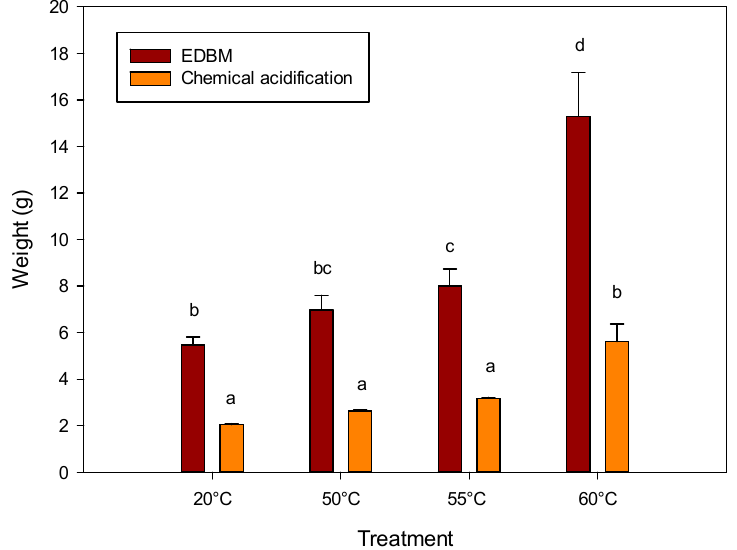
Figure 2. Weight of freeze-dried precipitate fractions generated at pH 4.8 after both acidification methods. The results are presented as the means ± standard deviation of three independent experiments. The use of different lowercase letters (a, b, c, d) indicate significant statistical differences between data.